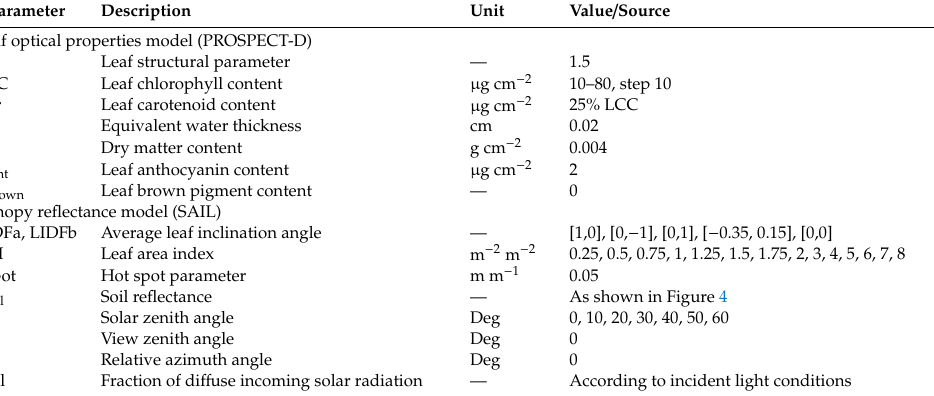
Table 5. Specific parameters input to the PROSAIL-D model for generating simulated spectra and the